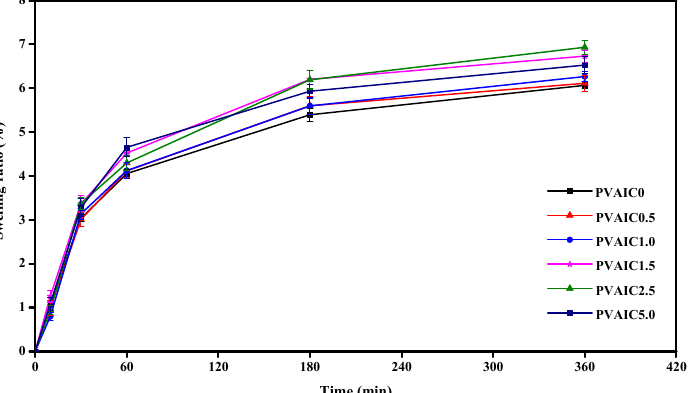
Figure 4. Swelling ratios of PVA hydrogels containing 0% (PVAIC0), 0.5% (PVAIC0.5), 1.0% (PVAIC1.0), 1.5% (PVAIC1.5), 2.5% (PVAIC2.5), and 5.0% (PVAIC5.0) quercetin/HP- β -CD inclusion complex. Data shown as mean ± standard deviation (n = 3).